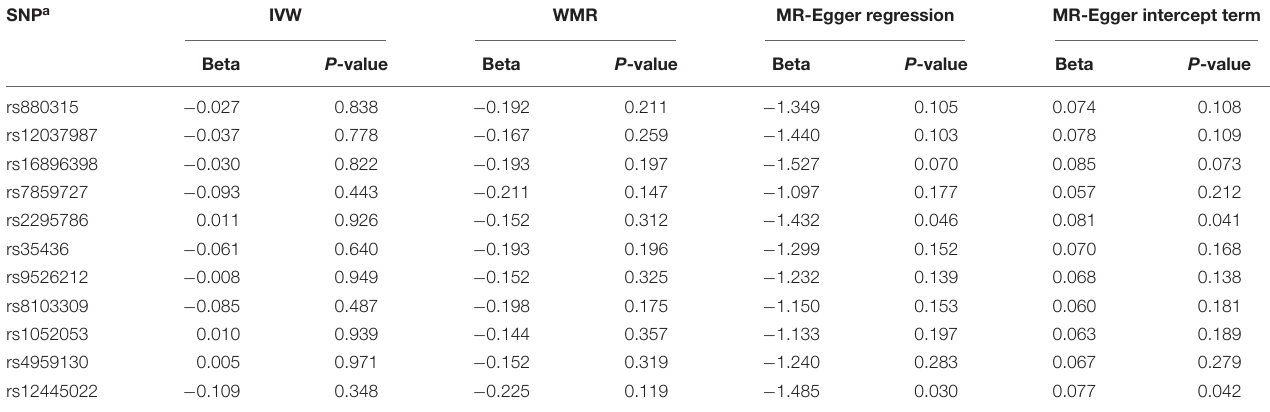
TABLE 6 | The results for sensitive analysis of the selected 11 genetic variants.